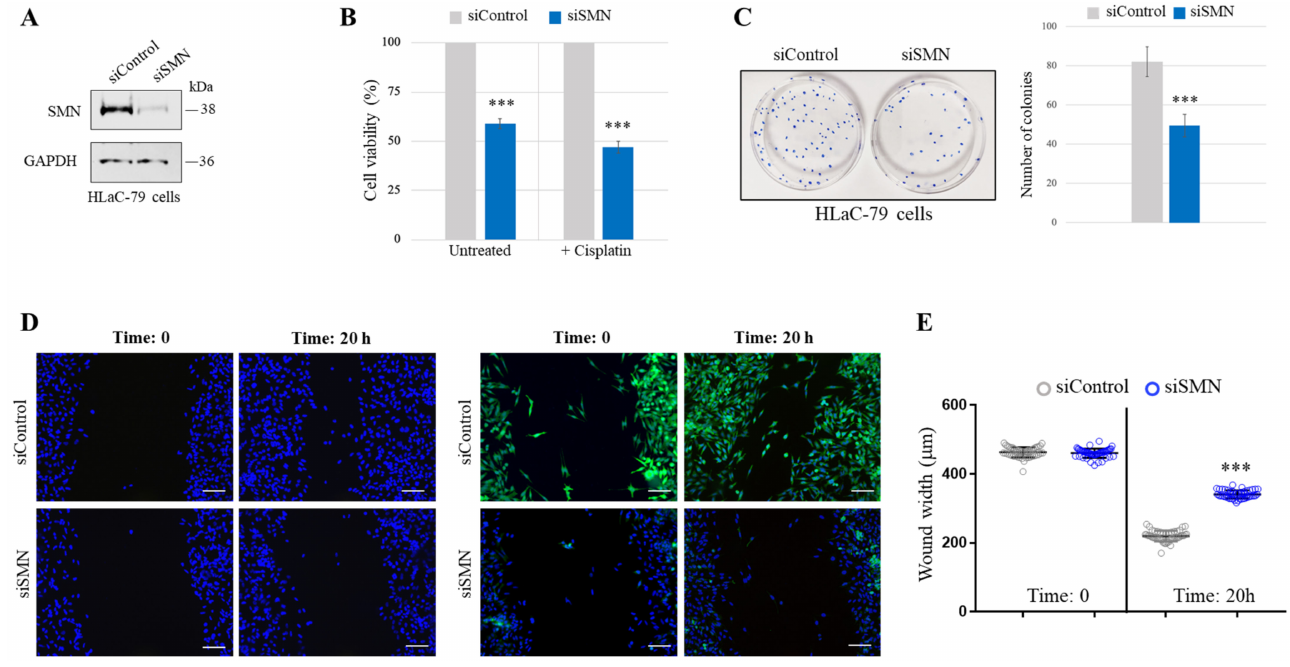
Figure 4. SMN knockdown affects cancer-relevant behaviors of HLaC-79 cells. ( A ) Western blot analysis of siControl- and siSMN-transfected HLaC-79 cells. Equal amounts of the protein